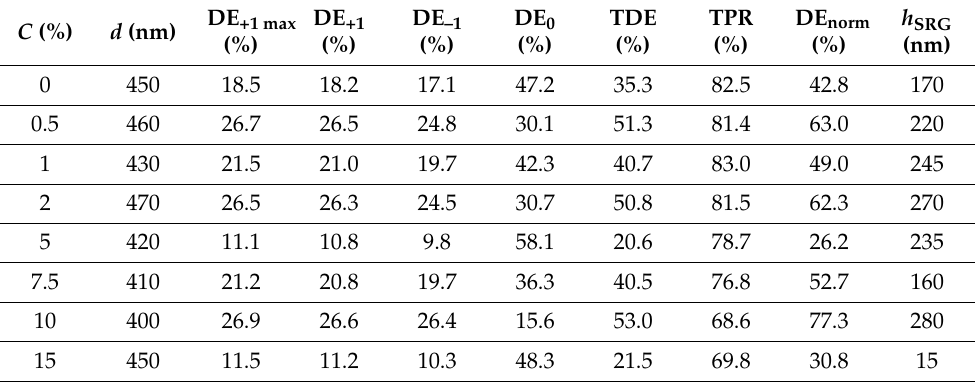
Table 1. Summary of the diffraction efficiency data for the recording angle 2 θ = 20 ◦